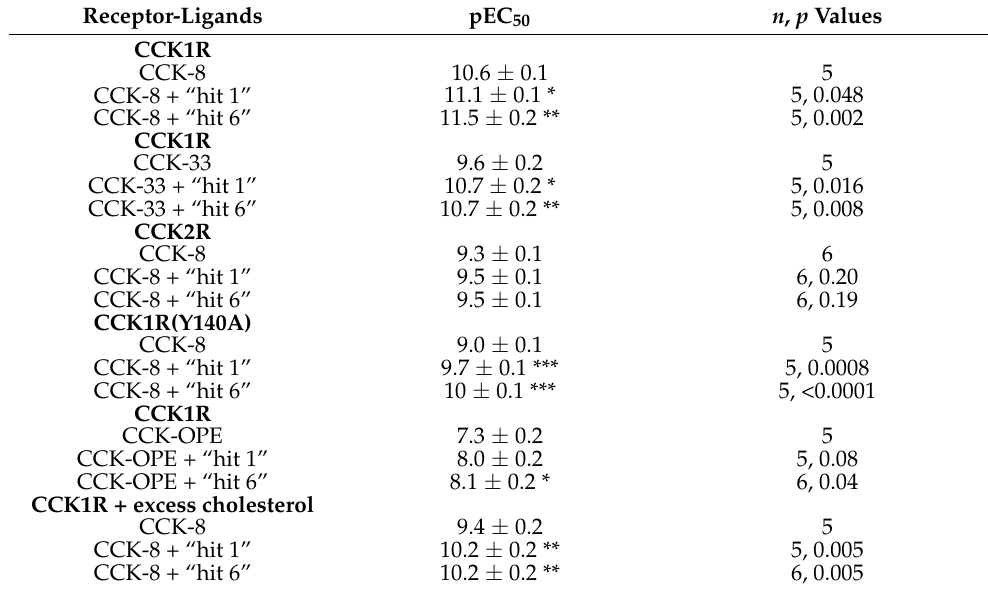
Table 1. Agonist-induced intracellular calcium responses in CHO cell lines in the absence and presence of PAM